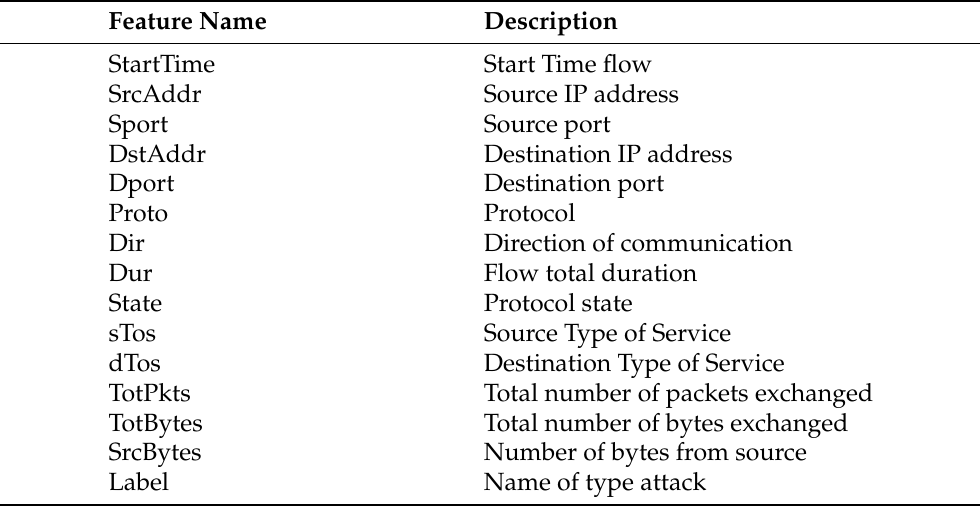
Table 2. CTU-13 list of